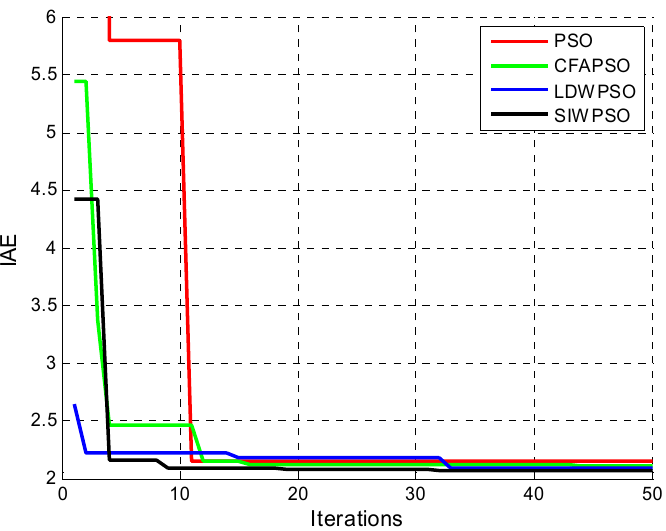
Figure 6. Plots of the IAE fitness values in Equation (21) for each iteration of the four PSO methods.